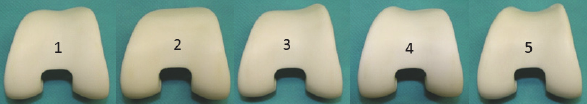
Figure 2: Design variations of Genesis II endoprosthesis with modified patellofemoral groove: (1) original design, (2) being flat, (3) being medially high, (4) being laterally high, and (5) both sides high.